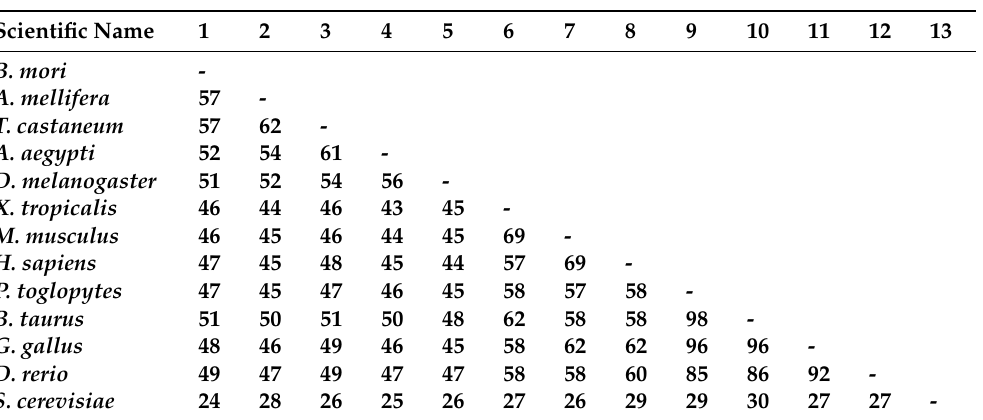
Table 1. Comparison of pairwise identifies of B. mori endoplasmic reticulum oxidoreductin 1 ( bEro1 ) gene and known eukaryotic ERO1